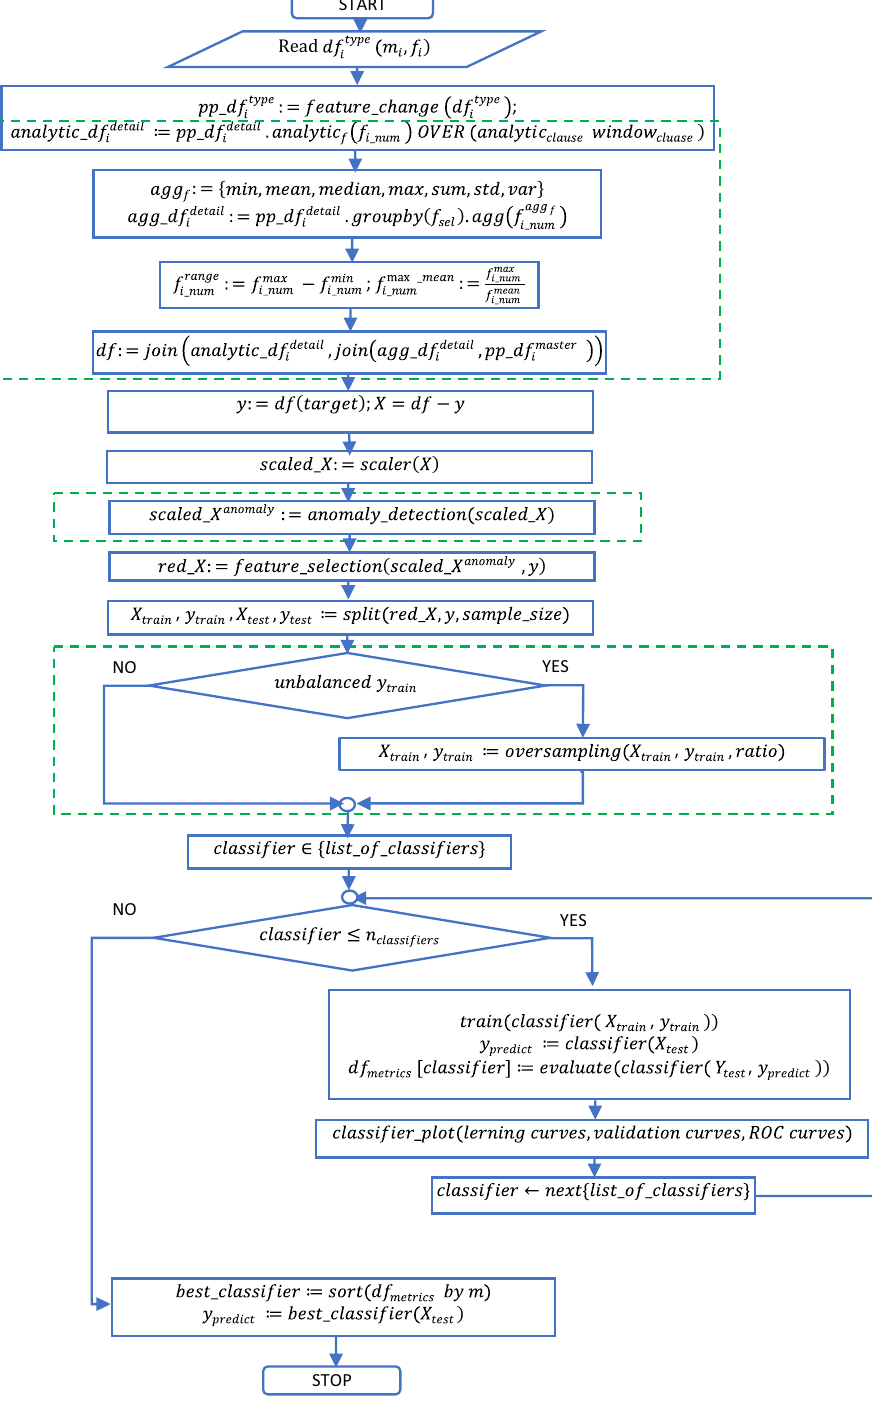
Figure 2. Flowchart of the electricity consumption fraud detection